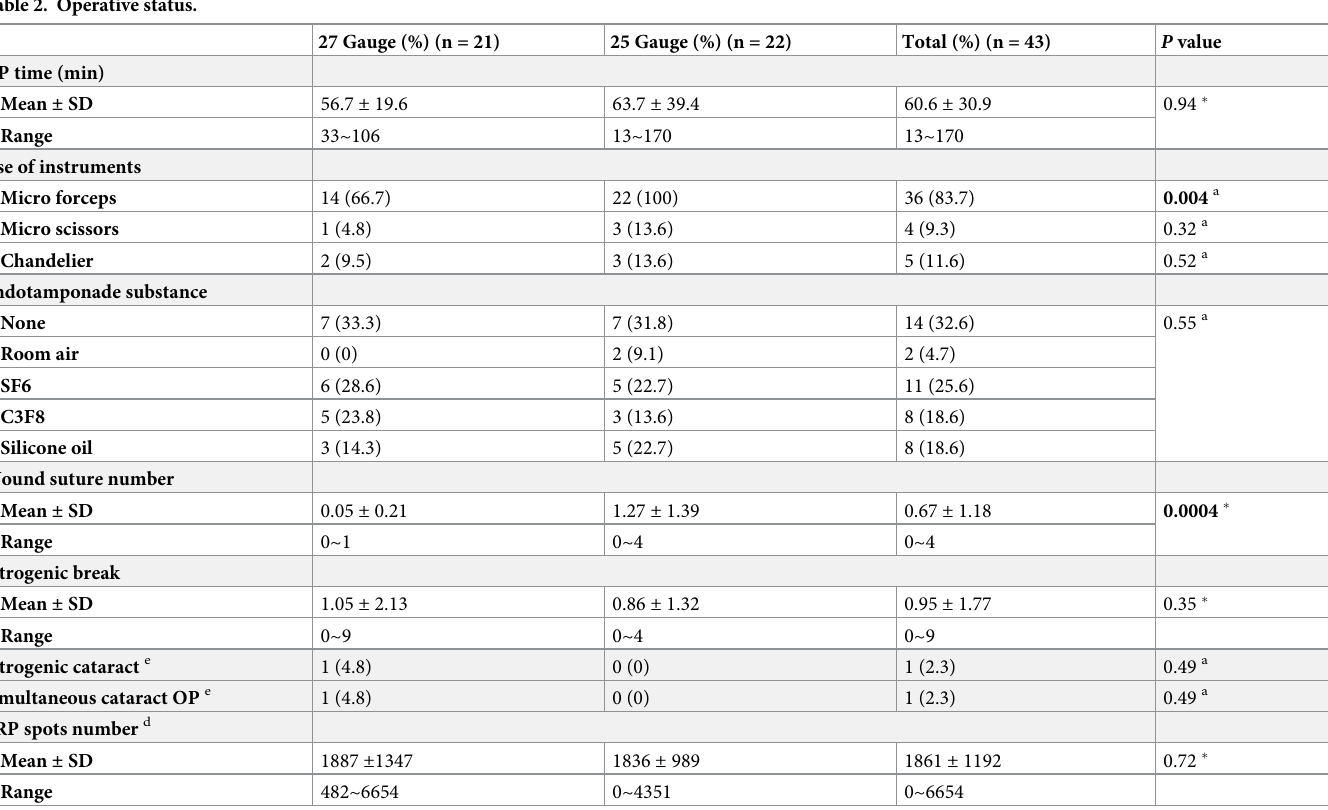
Table 2. Operative status.